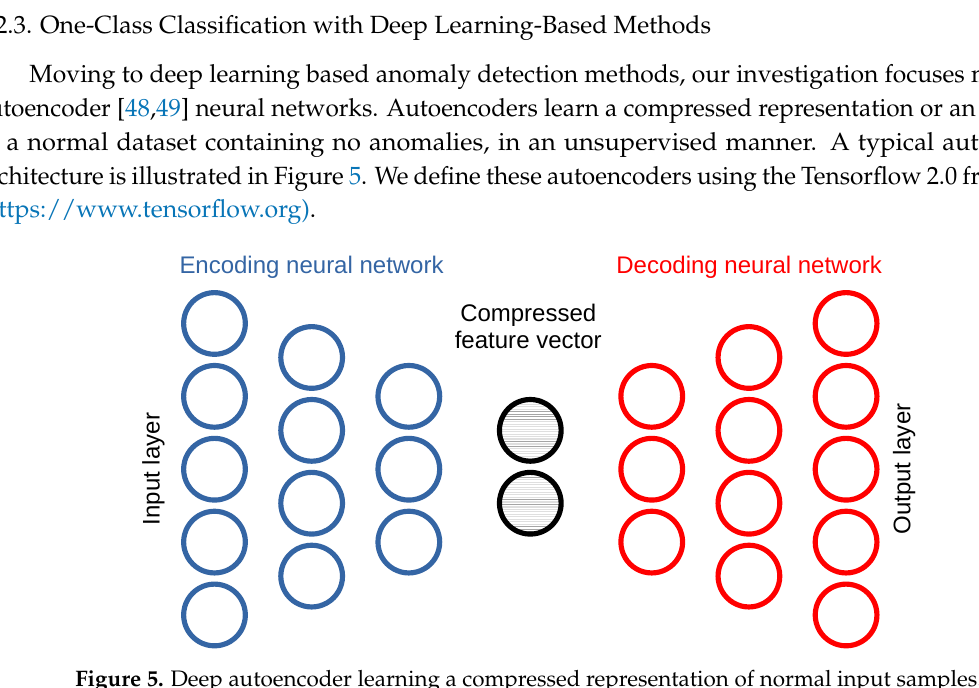
Figure 5. Deep autoencoder learning a compressed representation of normal input